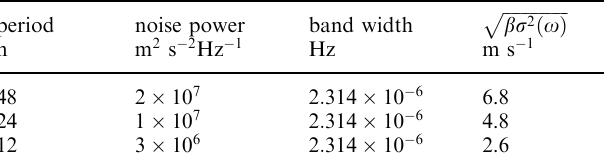
Table 1. An estimate of the amplitude o(cid:128)set due to the presence of geophysical noise. The bandwidth is consistent with an observing interval of 10 days and the noise power is estimated from Vincent and Lesicar (1991) period noise power band